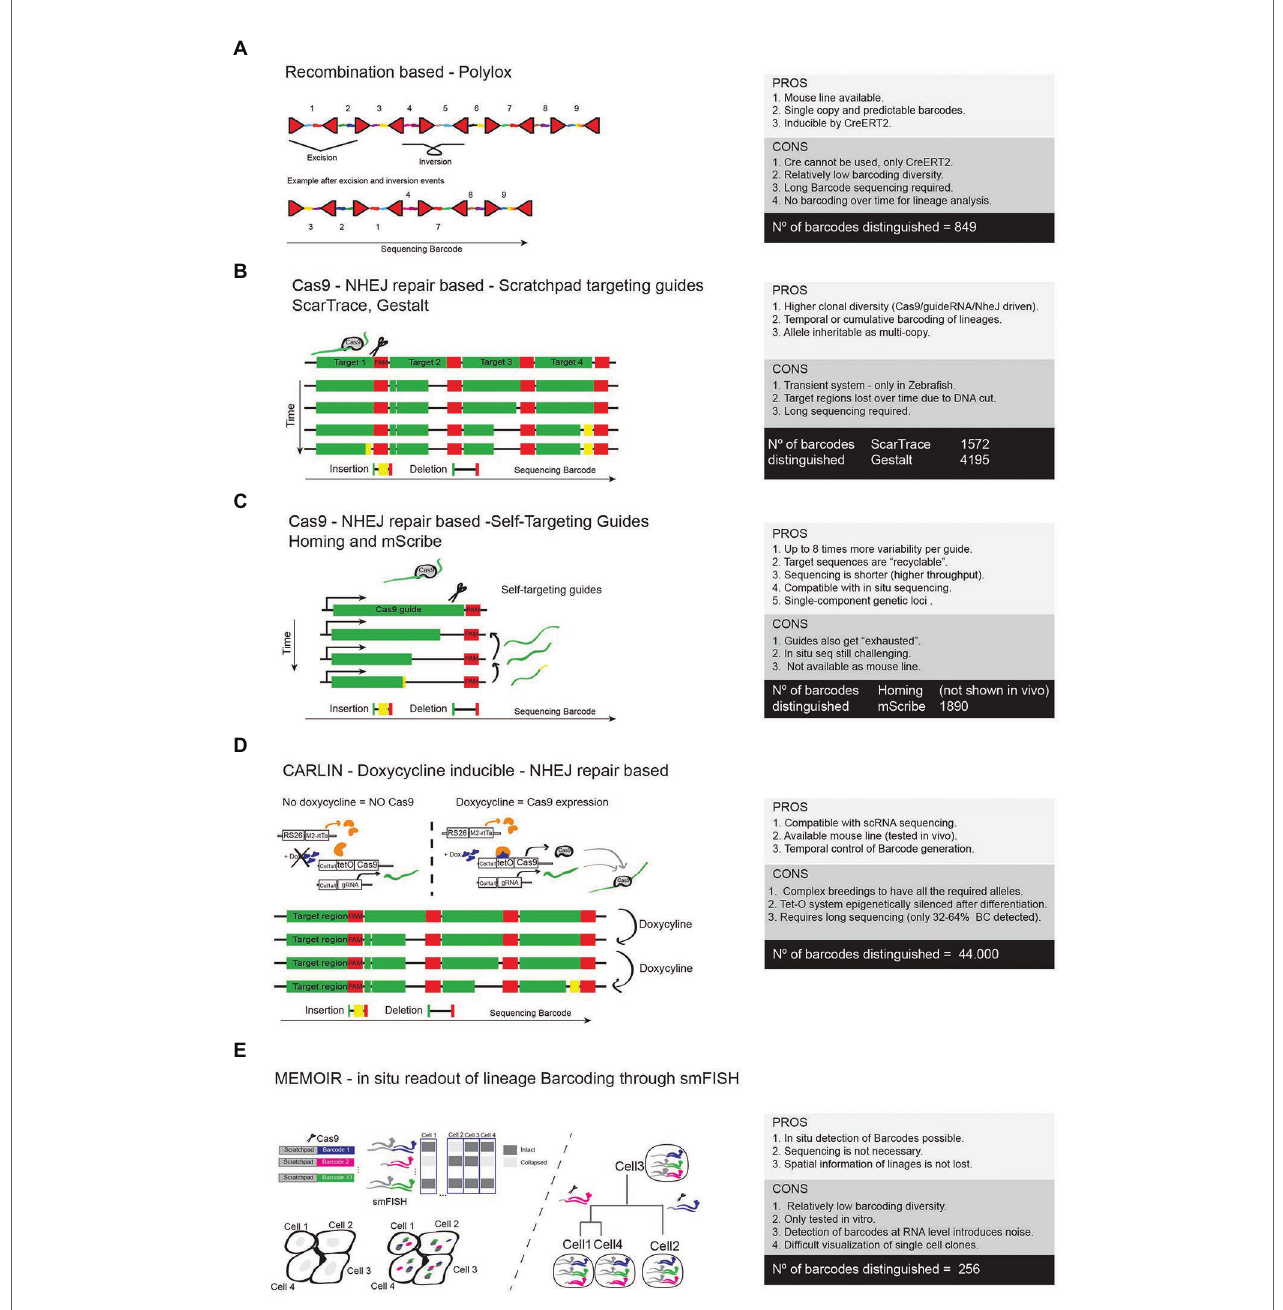
FIGURE 7 | High resolution lineage barcoding with Cre or Cas9. (A) Scheme of the allele and main features of the Polylox barcoding method. (B) Scheme representing the Cas9/NHEJ-based barcoding methods that rely on guides targeting a pre-designed genomic scratchpad to generate evolving gene editing events and barcoding diversity. (C) Methods using self-targeting guides to generate barcoding diversity. (D) The CARLIN mouse line is based on the method shown in B , but is inducible by doxycycline, allowing temporal control of the genetic barcoding. (E) The MEMOIR barcoding approach uses a guide RNA-targeted scratchpad linked to different genetic barcodes. Different cells will accumulate a different combination of edited (collapsed) barcodes that are detectable by smFISH and